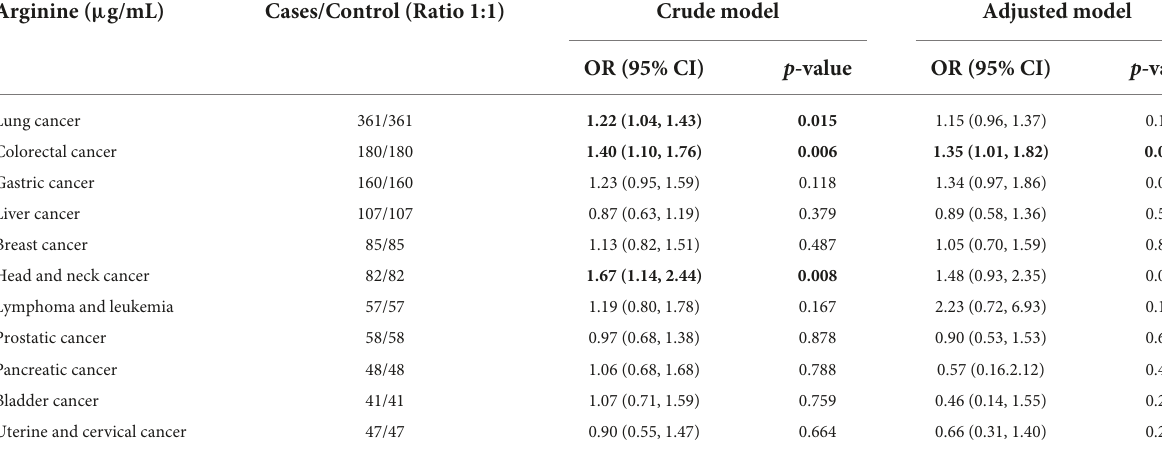
TABLE 4 The association of serum arginine (per SD) with site-specific cancer risk. Arginine ( µ